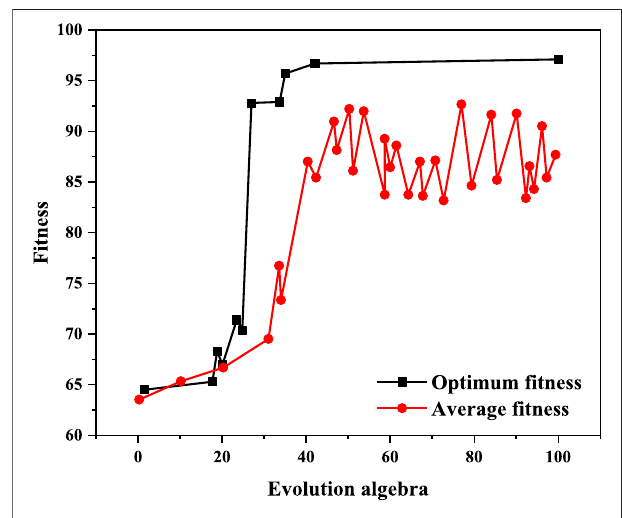
FIGURE 6 | Fitness curve of genetic algorithm. The optimal parameters of the support vector machine are C = 13.7926 and γ = 0.0079.